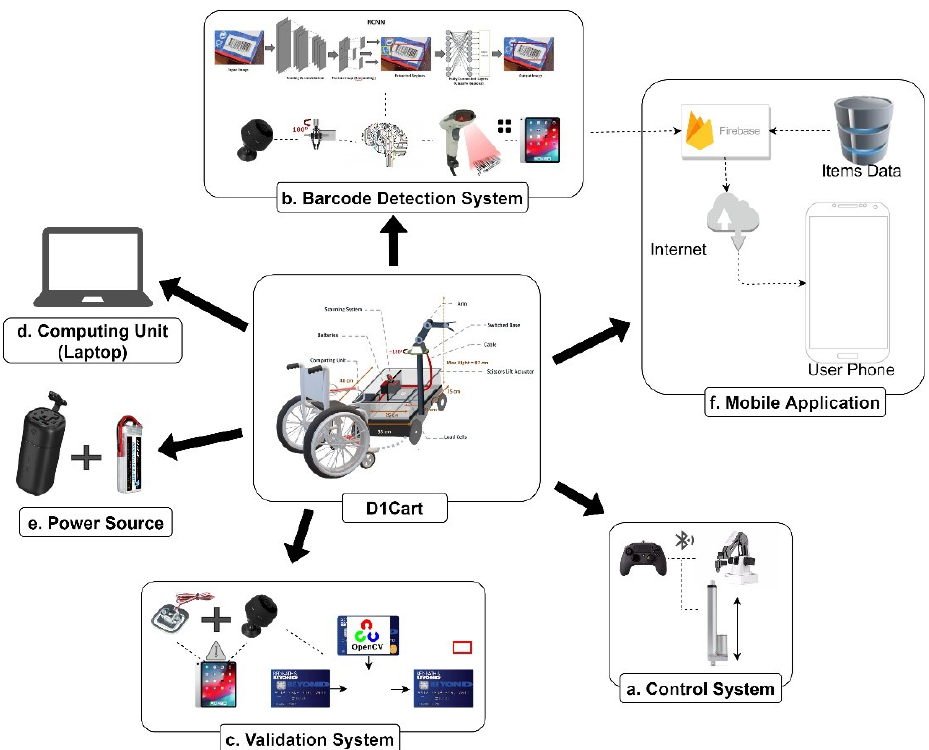
Figure 1. System